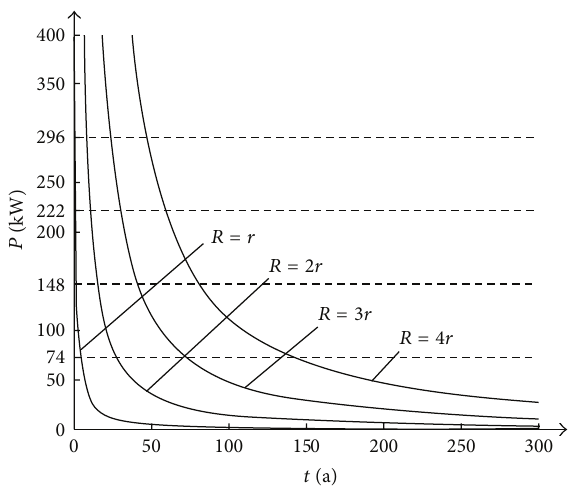
Figure 3: Heat variation and corresponding threshold of spheri- cal containers of radioactive waste with radii 116.9cm, 233.8 cm, 350.7 cm, and 467.6 cm.